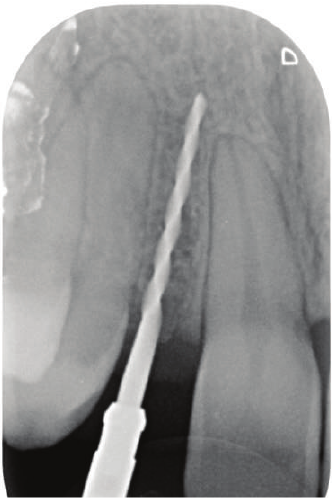
Figure 7: Radiographic examination of the correct inclination in site to the